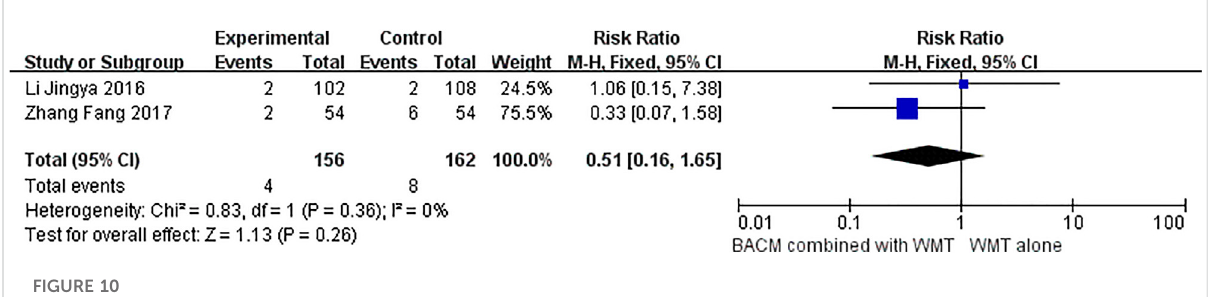
FIGURE 10 The forest plot of the incidence of mortality due to BACM for